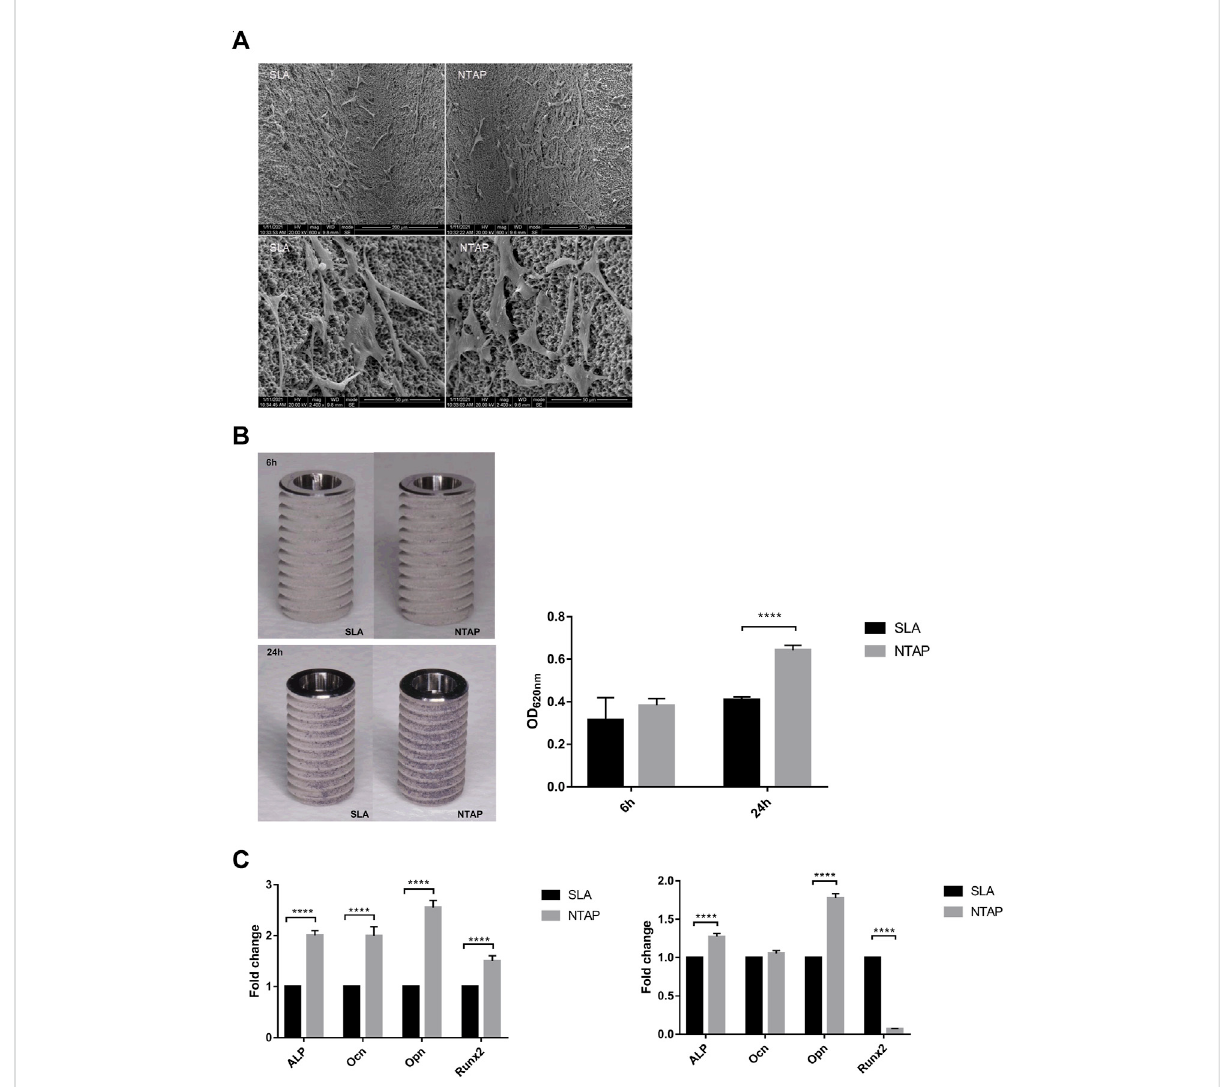
FIGURE 2 Biological behavior of MC3T3-E1 cells on NTAP and SLA implants. (A) Cell morphology at 12 h observed by SEM (magni fi cation: ×600 and ×2400). (B) Cell adhesion at 6 h and 24 h measured by crystal violet staining. (C) Expression of osteogenic differentiation-related genes ( alp , ocn , opn , and runx2 )ofMC3T3-E1 cells at7 days(left)and14 days (right) tested byRT-qPCR.Values represent themeansof dataobtained from three different experiments with standard deviations. **** = p < 0.001 of Student ’ s t test using IBM SPSS 26 (the error bars indicate standard